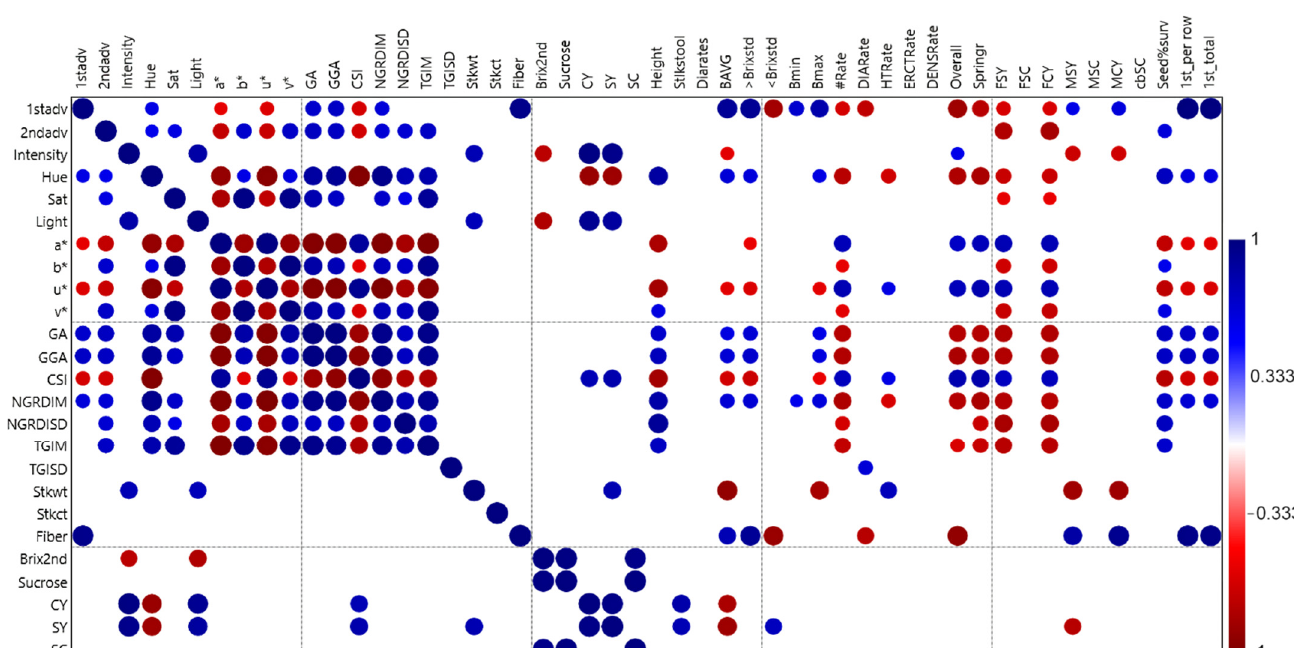
Figure 3. Corrogram of the remaining 25 selection, yield, and plant cane spectral traits taken on 2 July 2018. Only significant correlations are shown and the larger the circle the larger the correlation with color scale describing the correlation. Height, Stalk height (cm); stlkstool, stalks per stool; Diarates, Stalk diameter rating per stool; BAVG, Brix average from field brixing of 20 seedling stools; >Brixstd, Those selected greater than or equal to Brix standard in seedling trials; <Brixstd, Those not selected based on field Brixing less than field standard in seedling trials; Bmin, Minimum Brix of a family in seedling trials; Bmax, Maximum Brix of a family in seedling trials; #Rate, Seedling stalk number rating: 1 best and 9 worst; DIARate, Seedling diameter Rating: 1 best and 9 worst; HTRate, Seedling height Rating: 1 best and 9 worst; ERCTRate, Seedling erectness rating: 1 best and 9 worst; DENSRate, Seedling density rating: 1 best and 9 worst; Overall, Seedling overall Rating: 1 best and 9 worst; Springr, Seedling spring ratings; FSY, sugar per acre yield of female parent; FSC, sugar per ton yield of female parent; FCY, tons cane per acre yield of female parent; MSY, sugar per acre yield of male parent; MSC, sugar per ton yield of male parent; MCY, tons cane per acre yield of male parent; cbSC, Combined average of sugar per ton yield of both parents; Seed%surv, Seedling survival counts; 1st_per row, First line selections per row; 1st_total, Total first lines selected; 1stadv, Ratio of first lines selected from seedling stage; 2ndadv, Ratio of second lines selected from first line stage; Intensity, CIELab color component; Hue, hue angles in the a*b* plane of the CIELab color space and vary from 0 to 360 ◦ where 0 ◦ is red, 60 ◦ is yellow, 120 ◦ is green, and 180 ◦ is cyan; Sat, Saturation: defines the color purity from white to the corresponding primary color; Light, Lightness: represents the range from black to white with pure black having a value of zero and pure white having a value of ten; a*, The range from green to red; b*, The range from blue to yellow; u*, The scale from blue to red; v*, The scale from blue to green; GA, included the green area (GA), which is the proportion of green pixels in an image; GGA, The greener area (GGA) excludes yellow pixels that correlate with senescent leaves; CSI, the Crop Senescence Index (CSI) = (GA − GGA)/GA × 100; NGRDIM, Mean of the image the Normalized Green–Red Difference Index (Rg − Rr)/(Rg + Rr); NGRDISD, Standard Deviation of NGRDI; TGIM, Mean of the image Triangular Greenness Index − 0.5[( λ r − λ b)(Rr − Rg) − ( λ r − λ g)(Rr − Rb)]; TGISD, Standard Deviation of the TGI; Slkwt, Stalk weight of second line trials; Stkct, Stalk count of second line plots; Fiber, % fiber calculated from 10 stalk sample in second lines; Brix2nd, Second Line Brix; Sucrose, % Juice sucrose content; CY, Cane yield Mg ha − 1 ; SY, Sugar yield Mg ha − 1 ; SC, g kg − 1 Theoretical recoverable